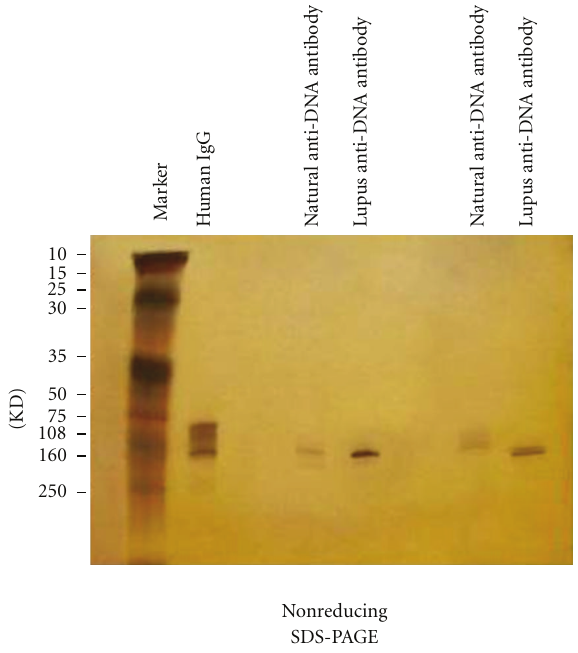
Figure 5: Electrophoretic analysis of the purity of anti-DNA antibody purified via two-step a ffi nity method employing magnetic